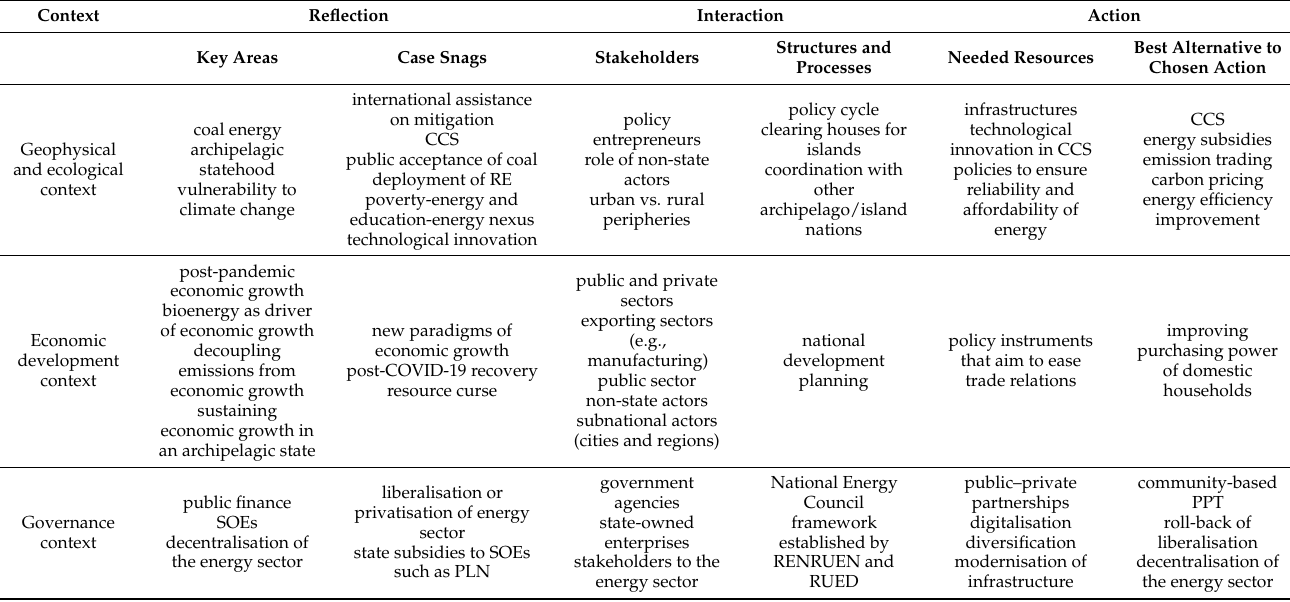
Table 3. Selected contexts of the Indonesian energy transition—Learning Activation